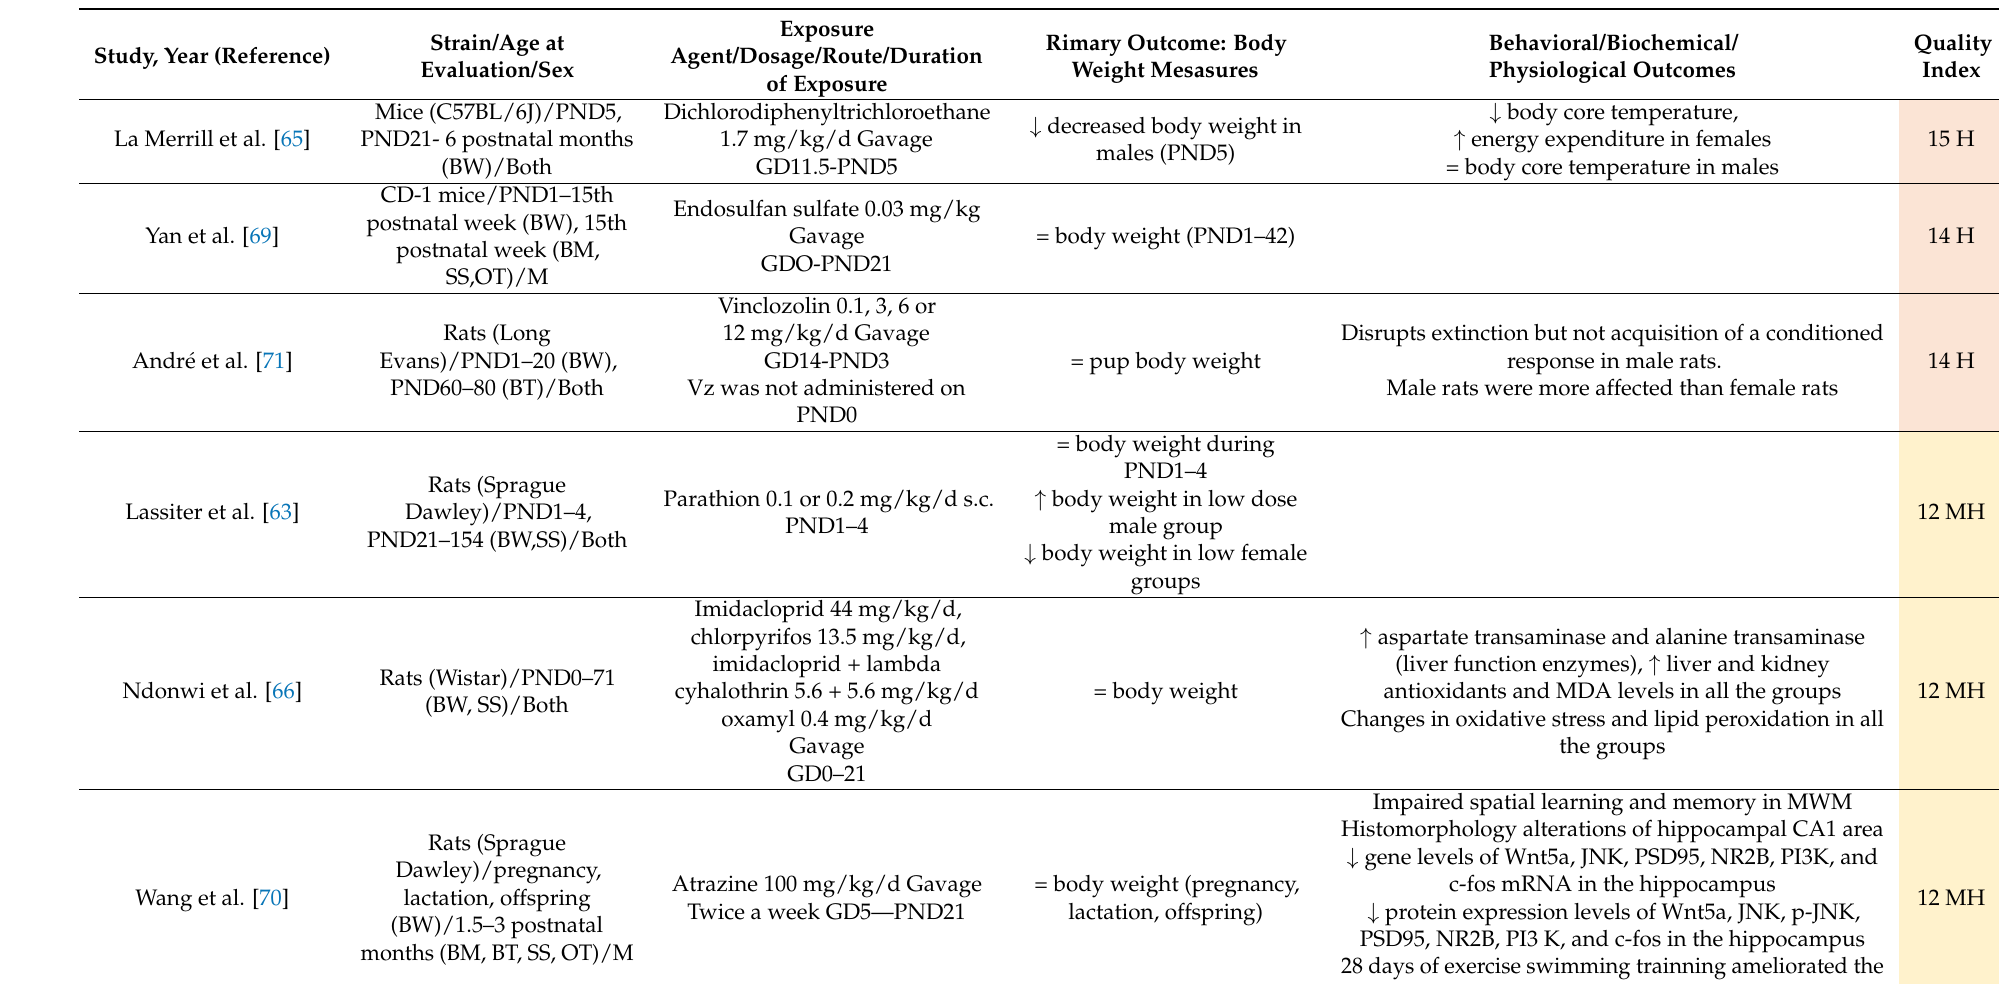
Table 2. Effects of pesticides exposure on risk of obesity in mice and